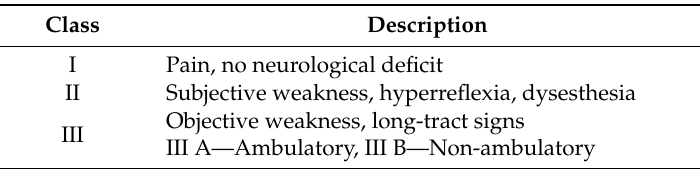
Table 3. Ranawat classification